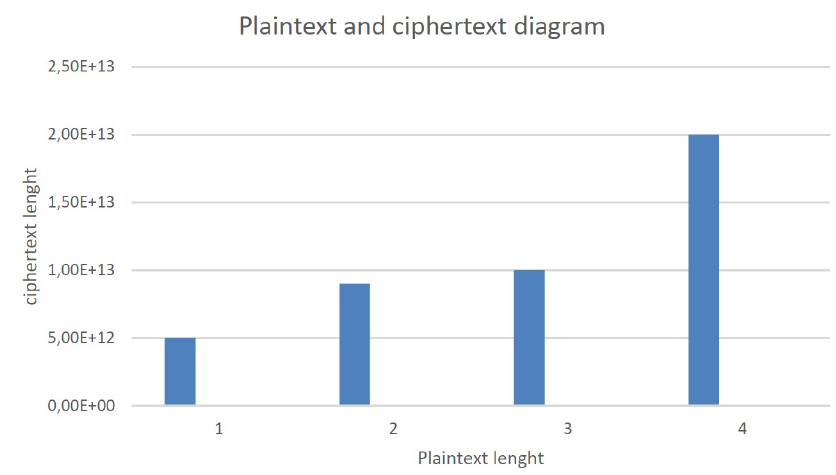
Fig. 1 Relationship between the plaintext and ciphertext